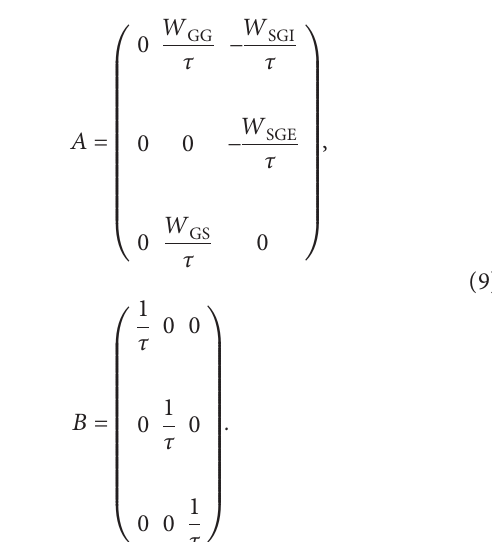
( x ) and F ( x ) . (b) Derivatives of activation functions F S G